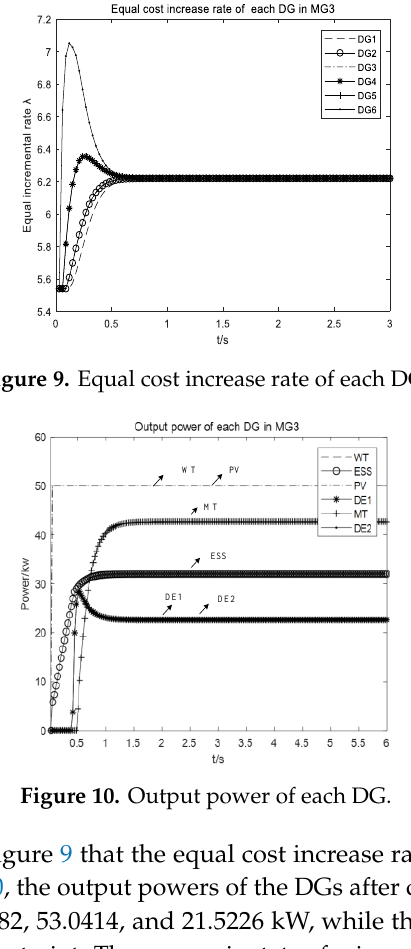
Figure 10. Output power of each DG.